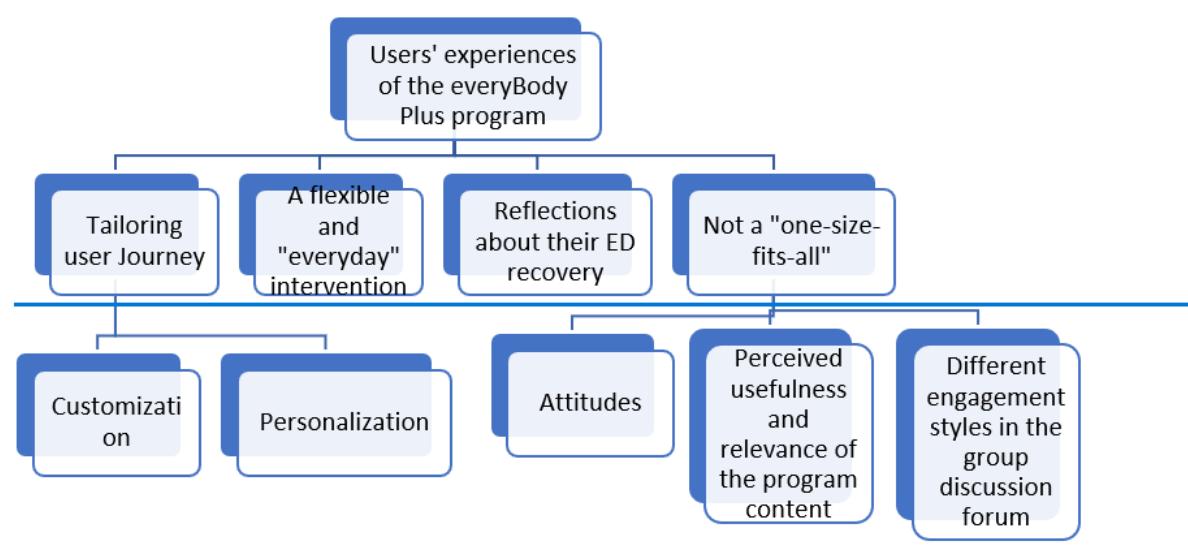
Figure 3. Coding tree. ED: eating